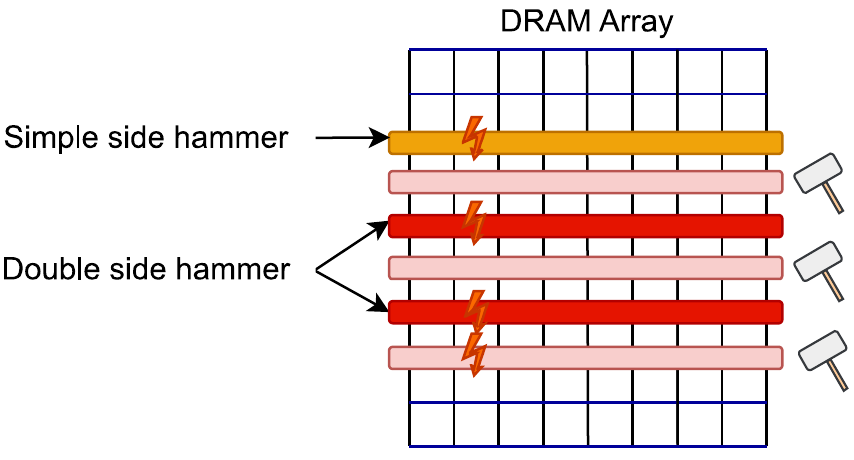
Figure 5. Situations of single-side hammer and double-side